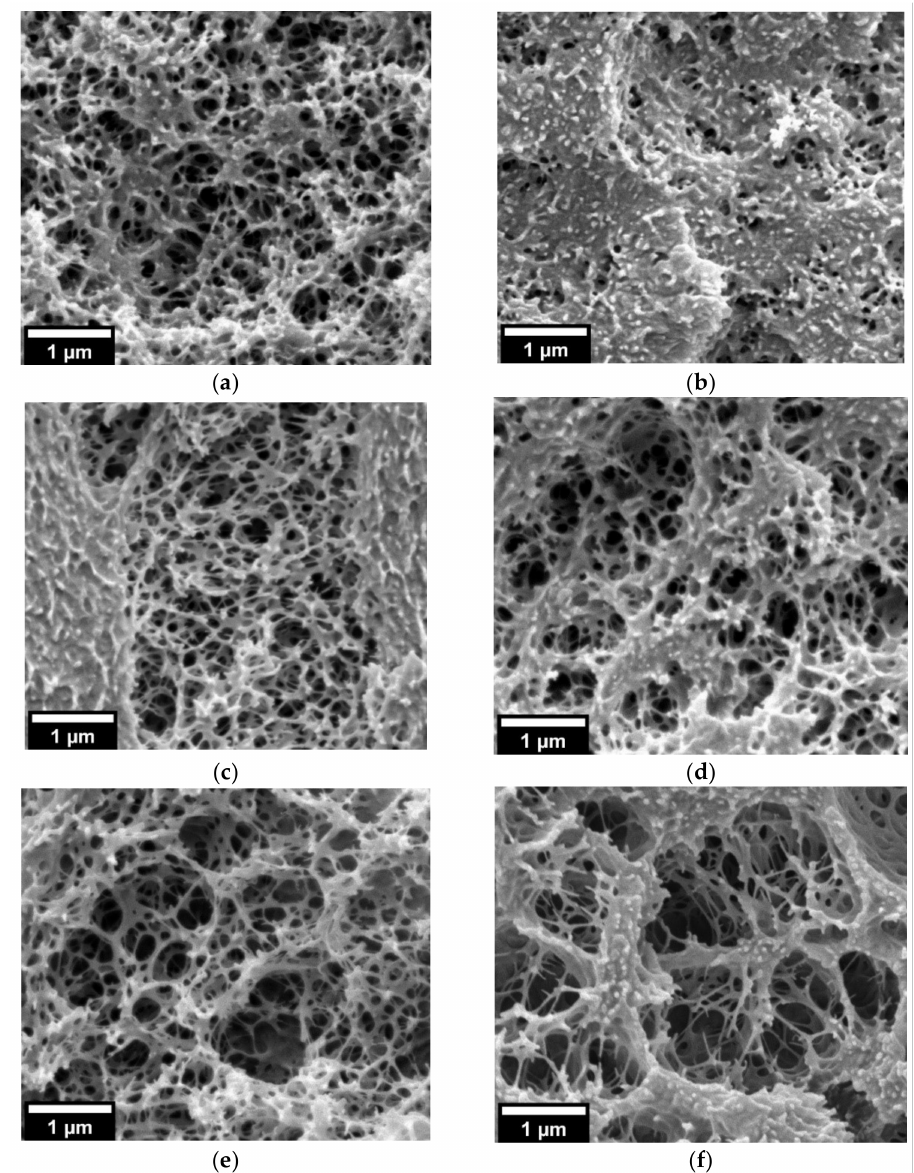
Figure 3. HRSEM micrographs of the cellular structure of the 25/75 PMMA/MAM foams obtained from bulk samples (left) and films (right) at 30 MPa and different saturation temperatures ( a , b ) 40 ◦ C; ( c , d ) 50 ◦ C; ( e , f ) 60 ◦